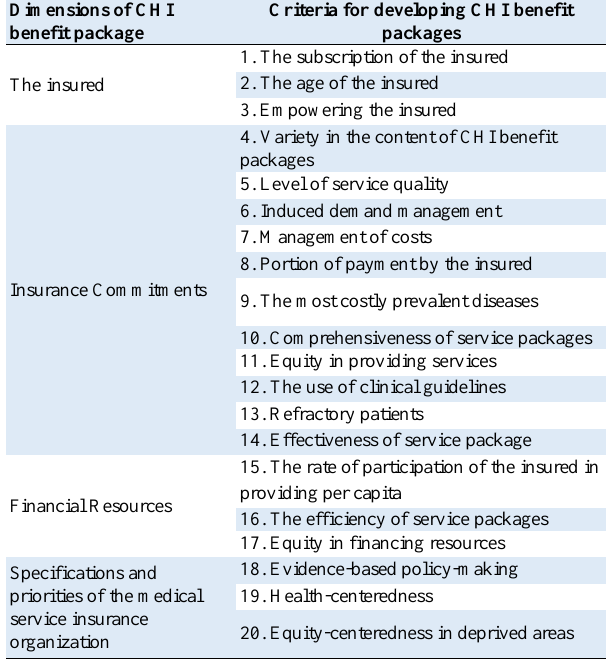
Table 2. Criteria for developing CHI benefit packages Dimensions of CHI benefit